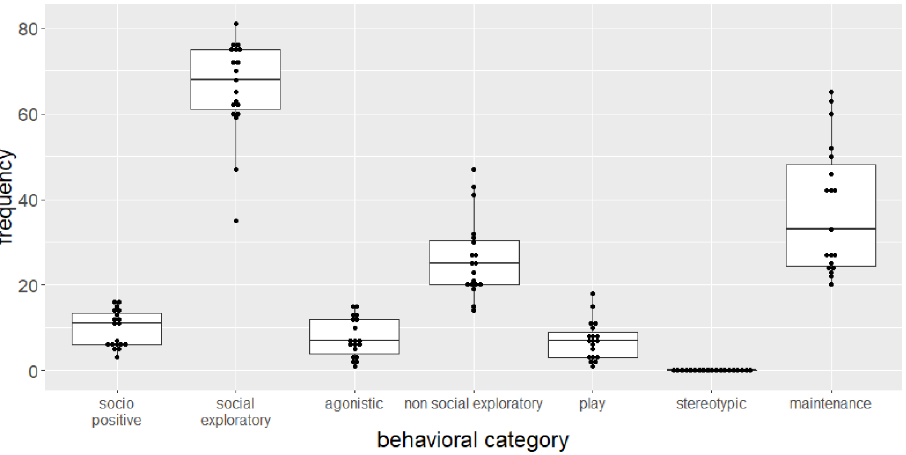
Figure 7. Mean frequency of behavior shown by female mice (n = 19) in the SNE during a cumulated 30 min observation period. Behavioral categories are combined from 28 possible behaviors to be observed.